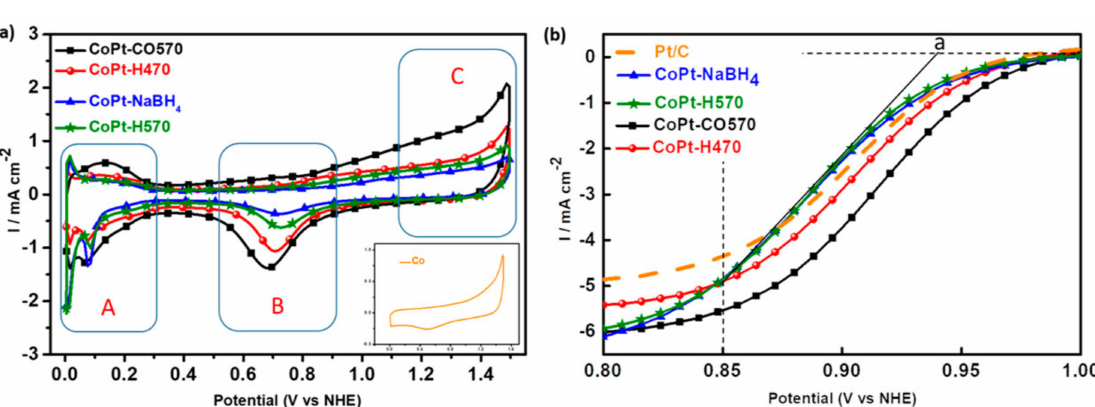
Figure 4. ( a ) The cyclic voltammetry and ( b ) linear sweep voltammetry curves of CoPt nanocatalysts (NCs) reduced in di ff erent environments. (Reproduced with permission from [40], American Chemical Society,